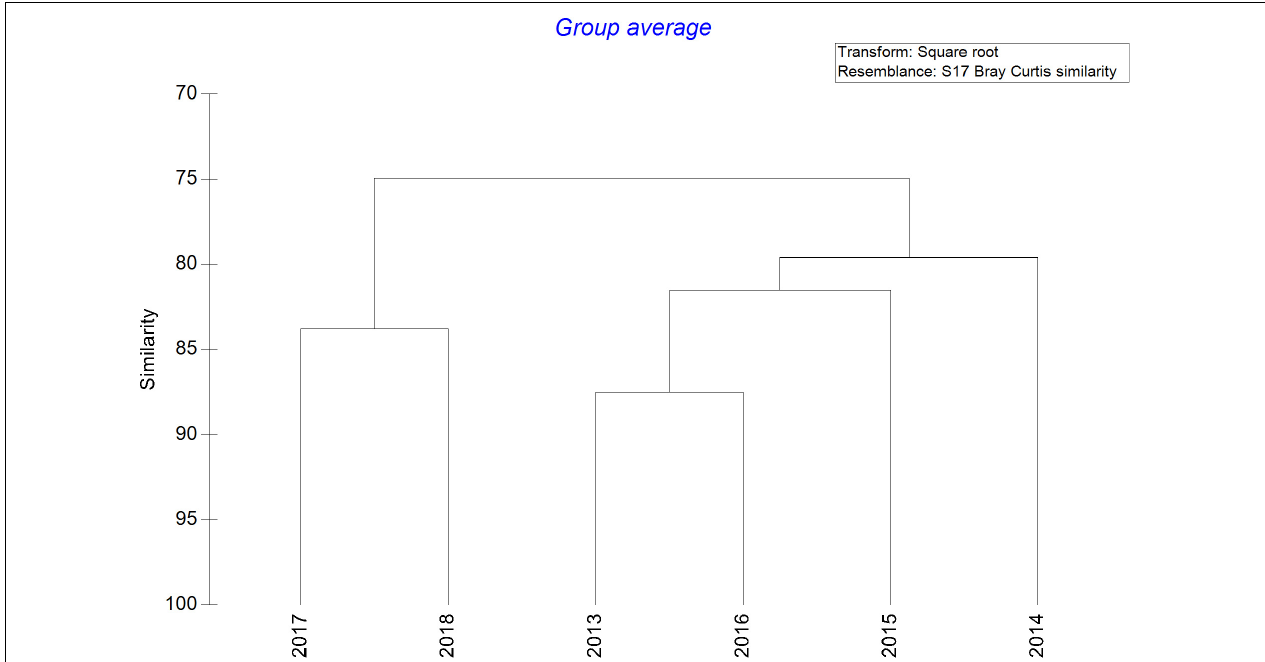
FIGURE 5 | Cluster dendrogram considering each year of the study after averaging the abundance of main zooplankton groups (ind m − 3 ) and square root transformation using resemblance of Bray Curtis similarity.